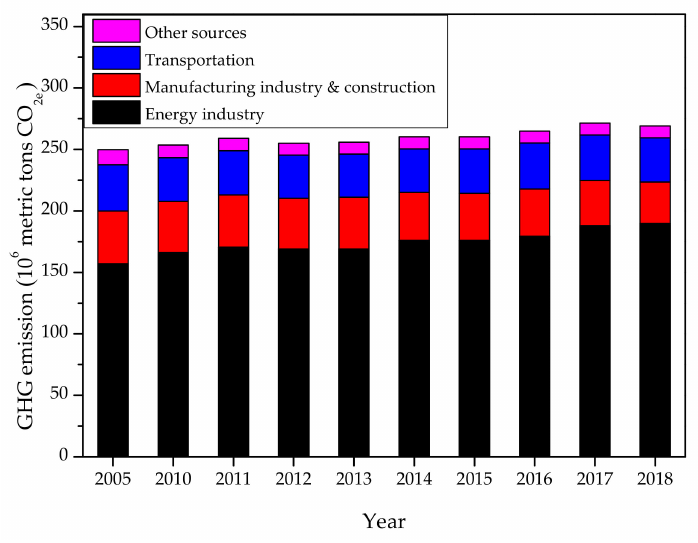
Figure 1. Variations on Taiwan’s GHG emissions from various sources in the energy sector